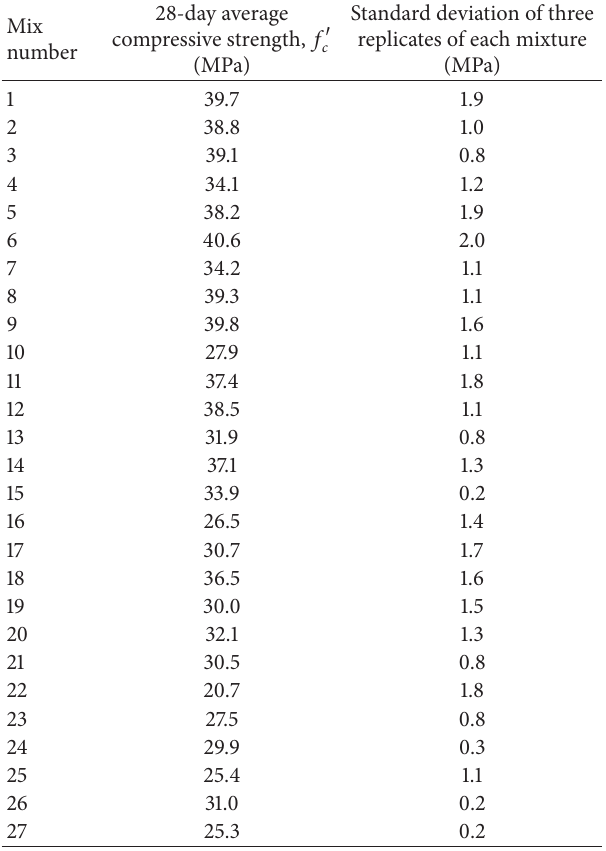
Table 4: Compressive strength test